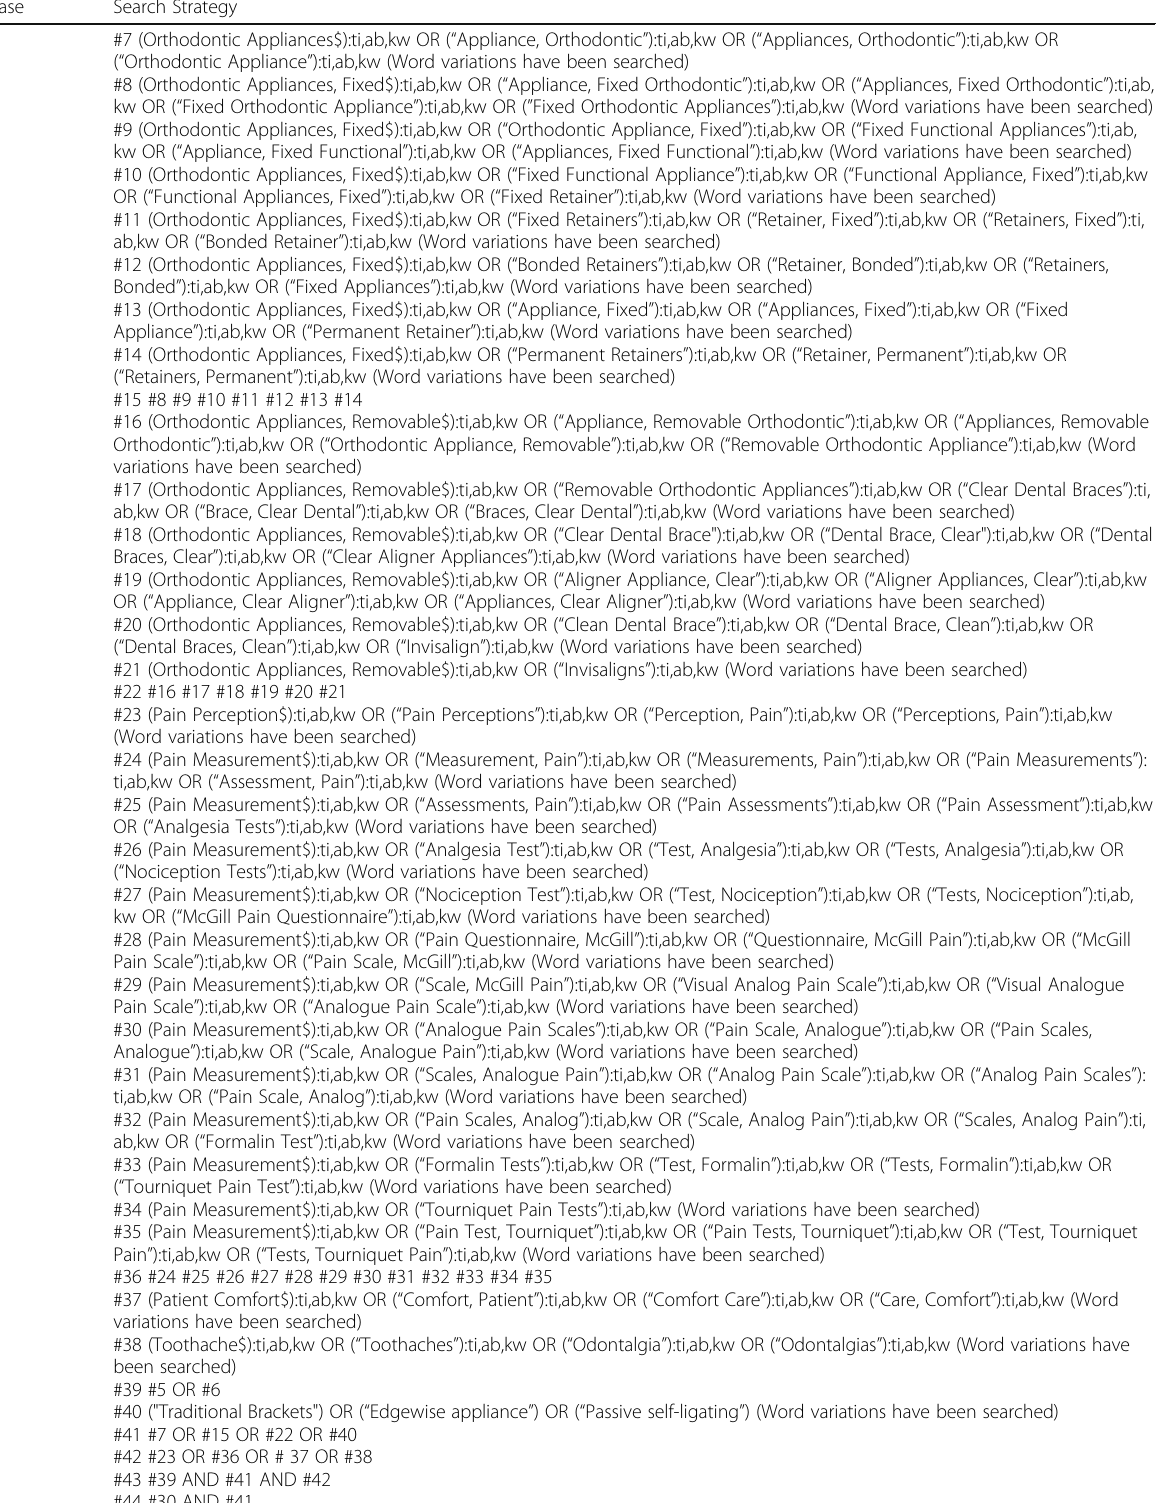
Table 8 Database and Search Strategy